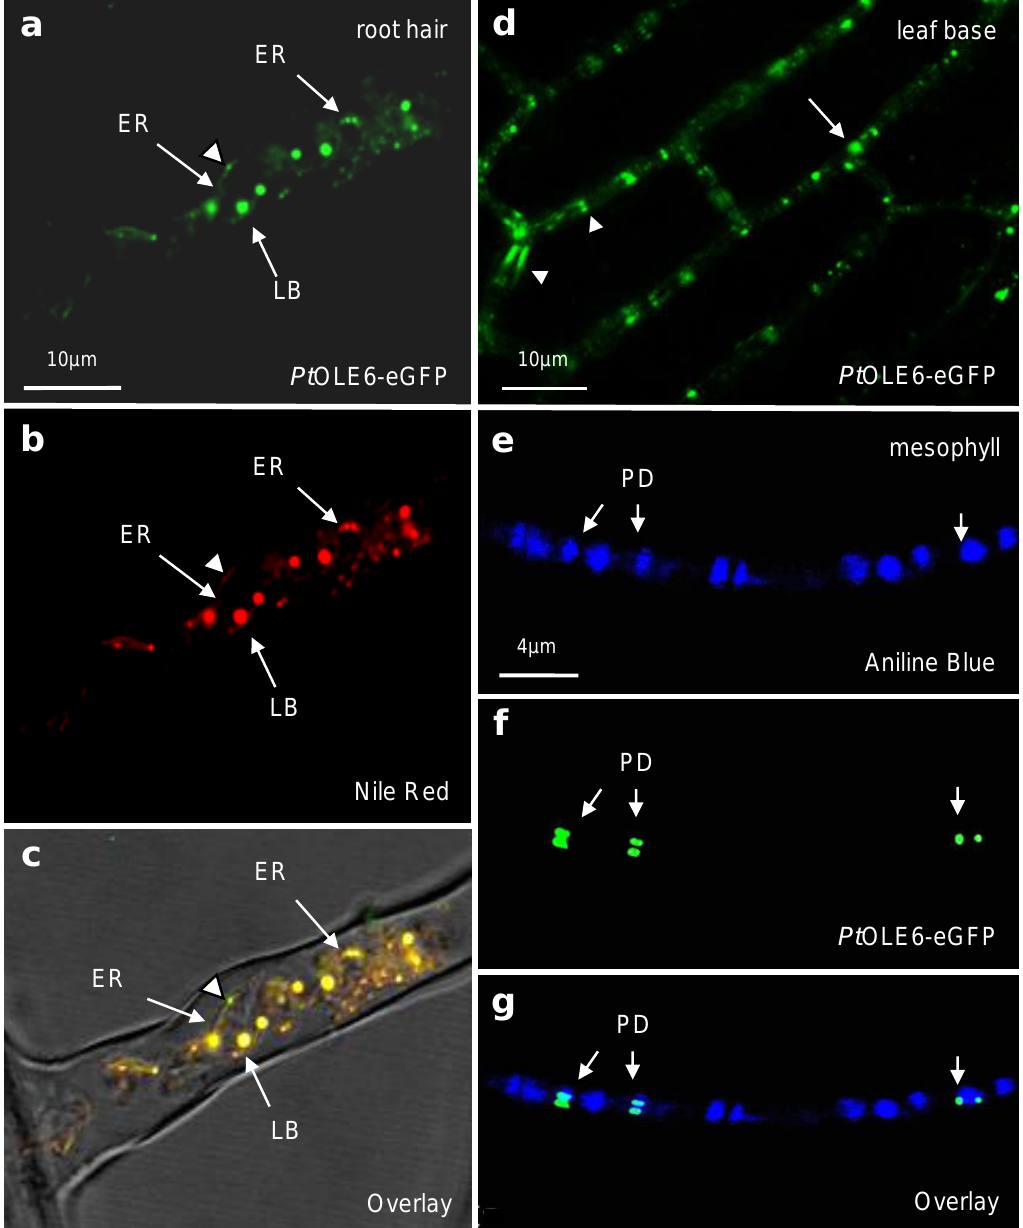
Figure 3. Transformation of Arabidopsis with PtOLE6-eGFP. ( a – c ) Root hairs, ( d ) leaf base, ( e – f ) mesophyll. ( a ) Pt OLE6-eGFP, and ( b ) Nile Red stained lipid bodies (LB) co-localize ( c , overlay). LBs at di ff erent growth stages appear associated with a membrane system, putatively endoplasmic reticulum (ER). Arrowhead indicates presence of OLEOSIN protein, prior to lipid deposition. ( d ) Pt OLE6-eGFP localizes to plasmodesmata (PD) in cells at the leaf base. Arrowheads indicate punctate and sandwich pattern at PD. Arrow indicates LB. ( e – f ) Callose, stained with aniline-blue ( e ) and Pt OLE6-eGFP ( f ), co-localize to subsets of plasmodesmata (PD) ( g , overlay). Pt OLE6-eGFP-tagged LBs target PD orifices in neighboring cells that share the PD-channel, thereby creating typical doublet